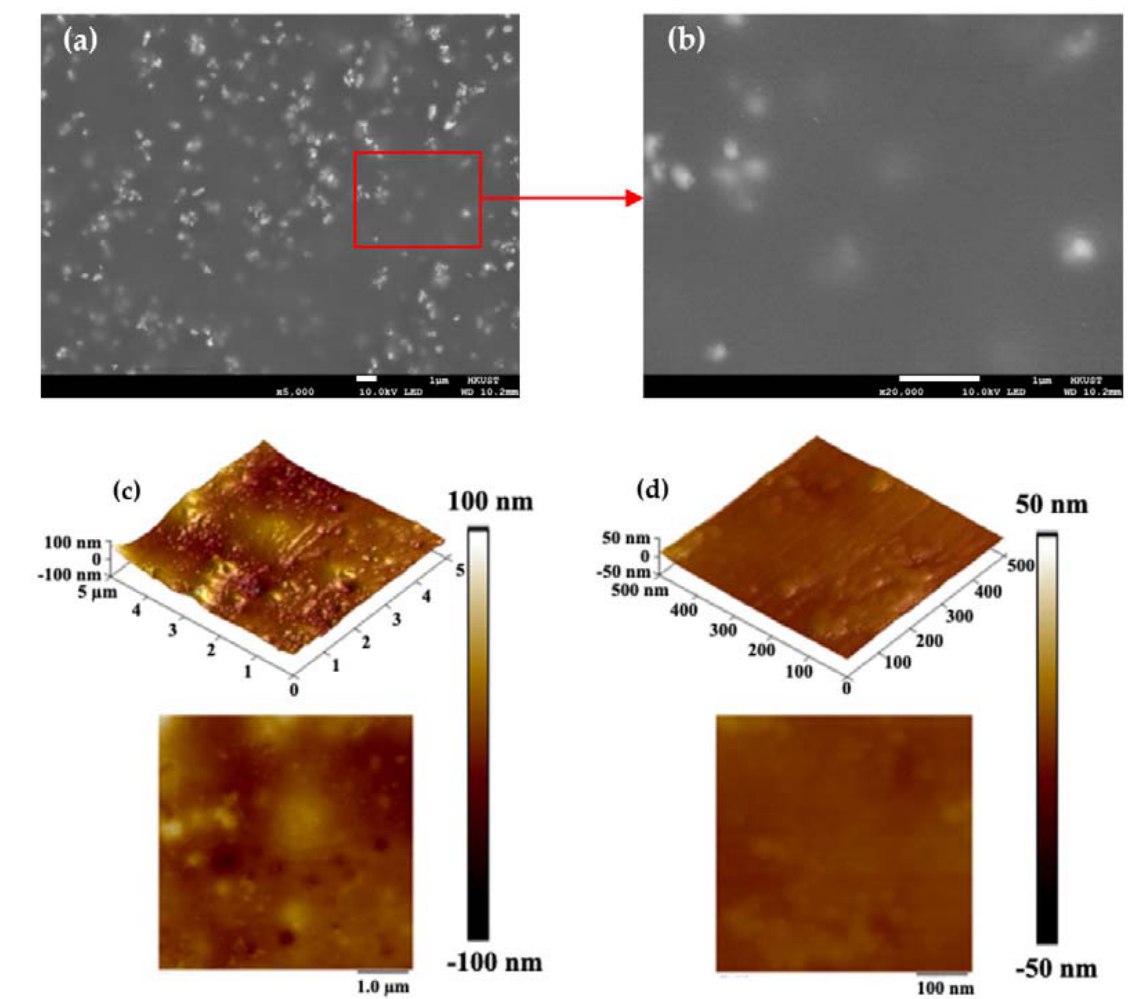
Figure 1. ( a , b ) The ×5000 and ×20,000 SEM images, respectively, for the coated reaction chamber surface of aluminum-based chip; ( c , d ) 3D and 2D tapping-mode AFM images of the coated chip surface from a 5 μ m × 5 μ m area and a 500 nm × 500 nm area, respectively.